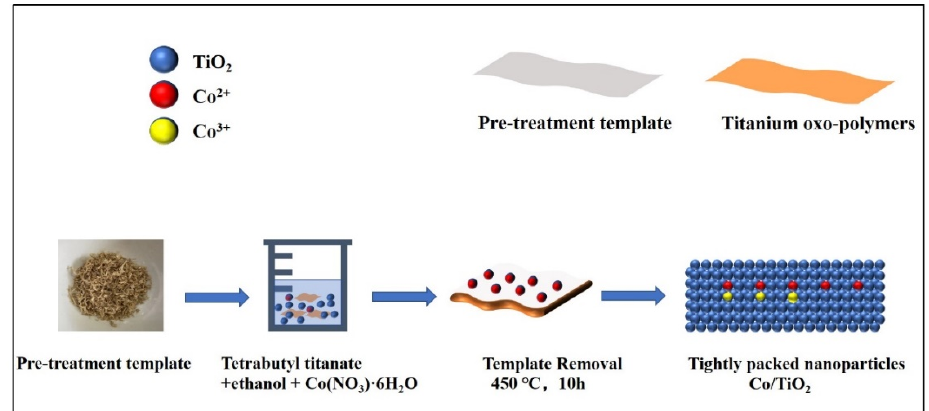
Figure 1. Schematic diagram of the synthesis through the one-pot impregnation method.